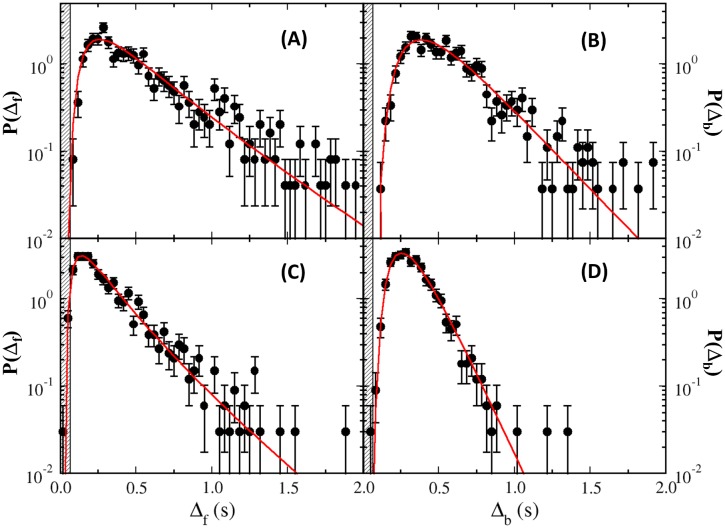
Dwell-time PDFs of YM4 in TMN (A–B) and TMN+phenol (C–D).The measurements and the fitting curves are displayed as black dots and red lines. Specifically, P(Δf) and P(Δb) are fitted by an inverse Gaussian distribution as described in main text. The shaded areas in these figures denote the short-time (66 ms) limitation of our measurements. Note that the time scales for the phenol data are significantly smaller than those measured without phenol.